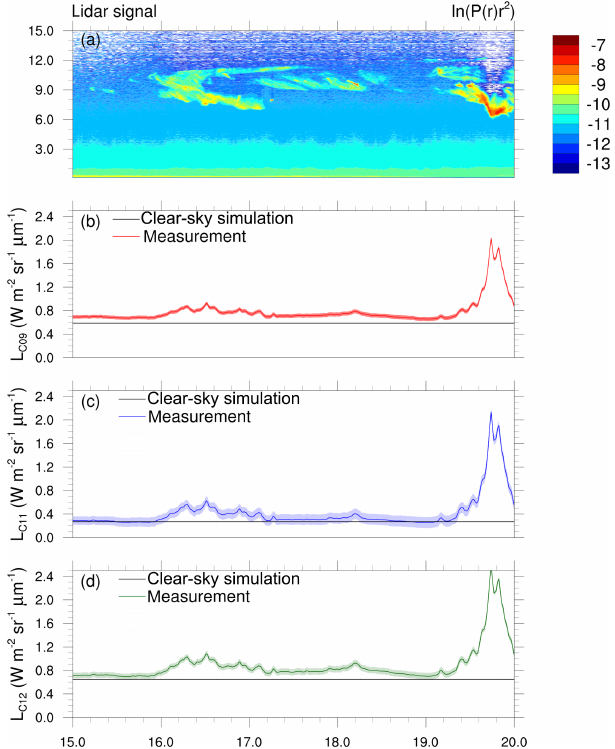
Figure 7. (a) Logarithm of the measured range-corrected lidar sig- nal for 30 November 2016, 15:00 to 20:00UTC. (b) TIR radiome- ter measurements for channel C09, (c) for channel C11 and (d) for channel C12. Shaded zones represent the error range of the mea- surement. The black lines in (b) to (d) represent the simulation with LIDORT for the three channels under cloud-free conditions taking into account the aerosol extinction in the lowest layers obtained from the lidar and water vapor and temperature profiles from an ECMWF reanalysis at